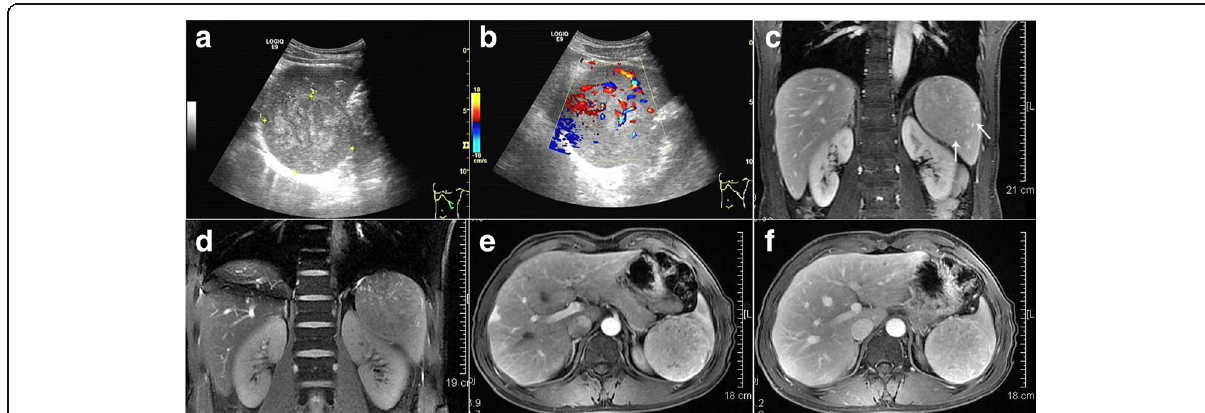
splenic parenchyma on arterial phase ( e ) and delayed phase ( f )